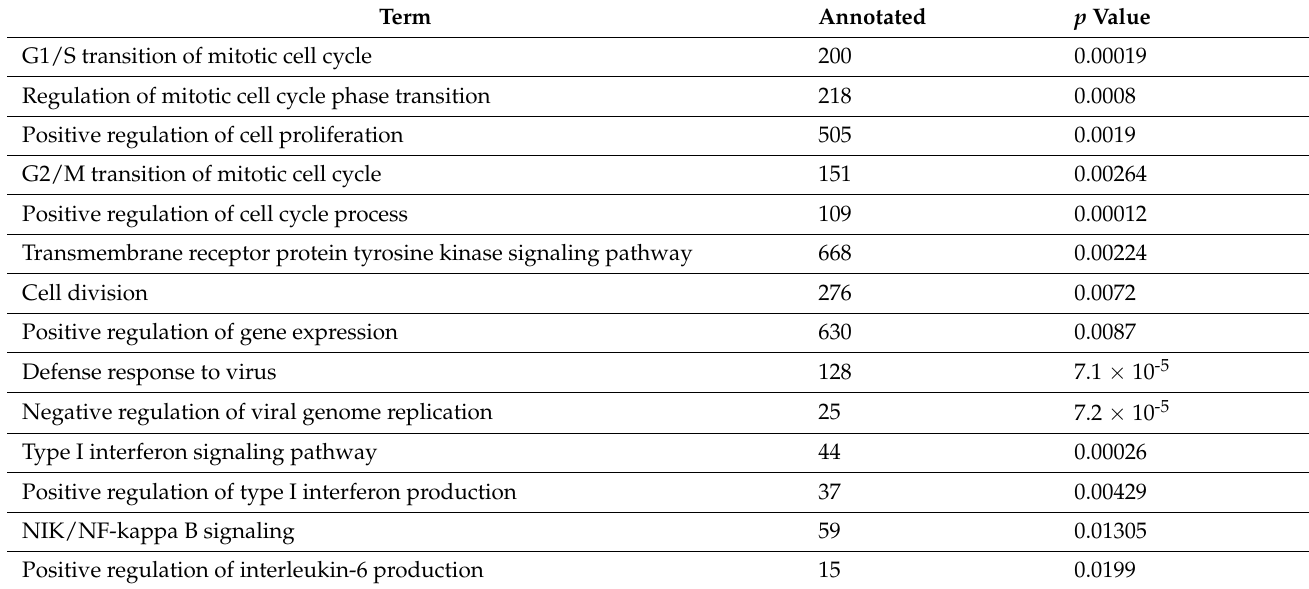
Table 2. Functional enrichment analysis in GO terms (upregulated).